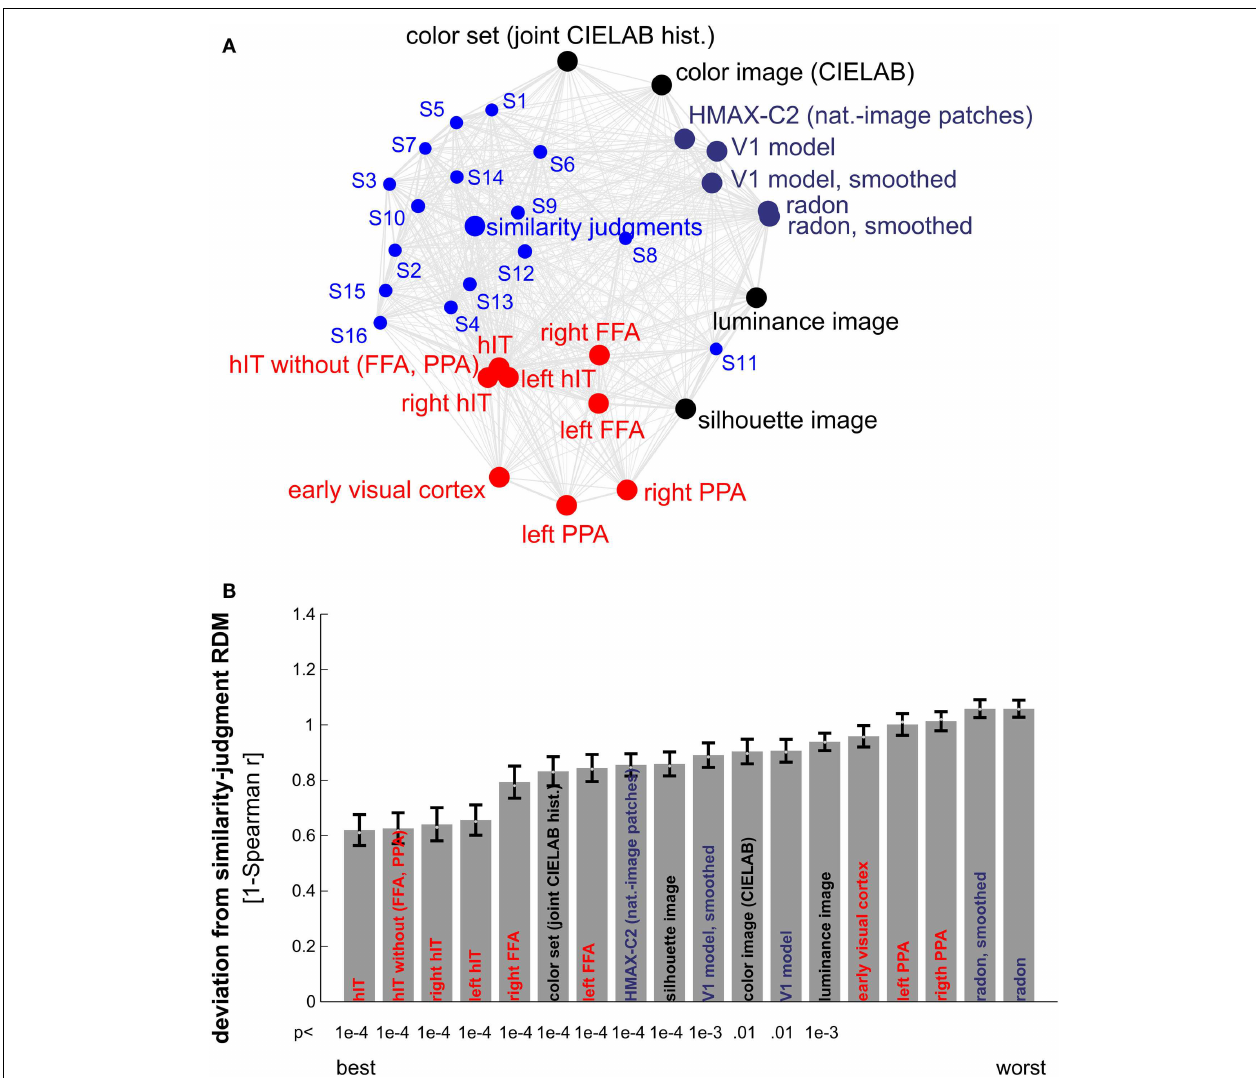
similarity representations in a lower-dimensional space (2D). (B) Match bars for several brain regions and models showing their deviation from the subject-average similarity judgment RDM.The deviation is measured as 1 − Spearman correlation between RDMs.Text color encodes the type of representation as in (A) . Error bars indicate the standard error of the deviation estimate.The standard error was estimated as the standard deviation of 100 deviation estimates obtained from bootstrap resamplings of the condition set.The p -value below each bar indicates whether the associated RDM is significantly related to the similarity judgment RDM (stimulus-label randomization test, 10,000 randomizations). hIT is the best match to the similarity